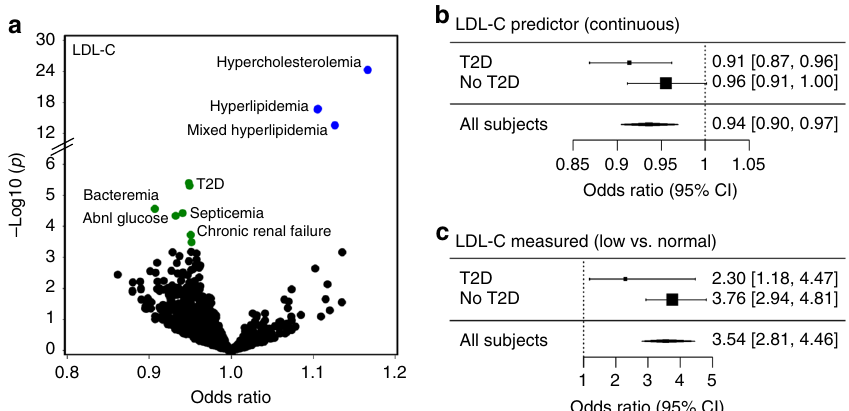
Fig. 5 Associations with LDL cholesterol (LDL-C). a Scatter plot summarizing pheWAS analyses for a genetic predictor of LDL-C. Blue and green colored circles denote associations that are signi fi cant at Bonferroni p < 0.05 and FDR q < 0.1, respectively. b Association analysis between the LDL genetic predictor and the PheWAS septicemia phenotype, strati fi ed by type 2 diabetes (T2D) status. Error bars represent 95% con fi dence intervals of odds-ratio estimates. c Epidemiological association between the Low (LDL-C < 60 mg/dl) versus Normal LDL-C (between 90 and 130 mg/dl) and septicemia, strati fi ed by T2D status, using an independent EHR cohort. Odds-ratios were determined by multivariable logistic regression adjusting for age, gender and race and strati fi ed by T2D status. Error bars represent 95% con fi dence intervals. T2D type 2